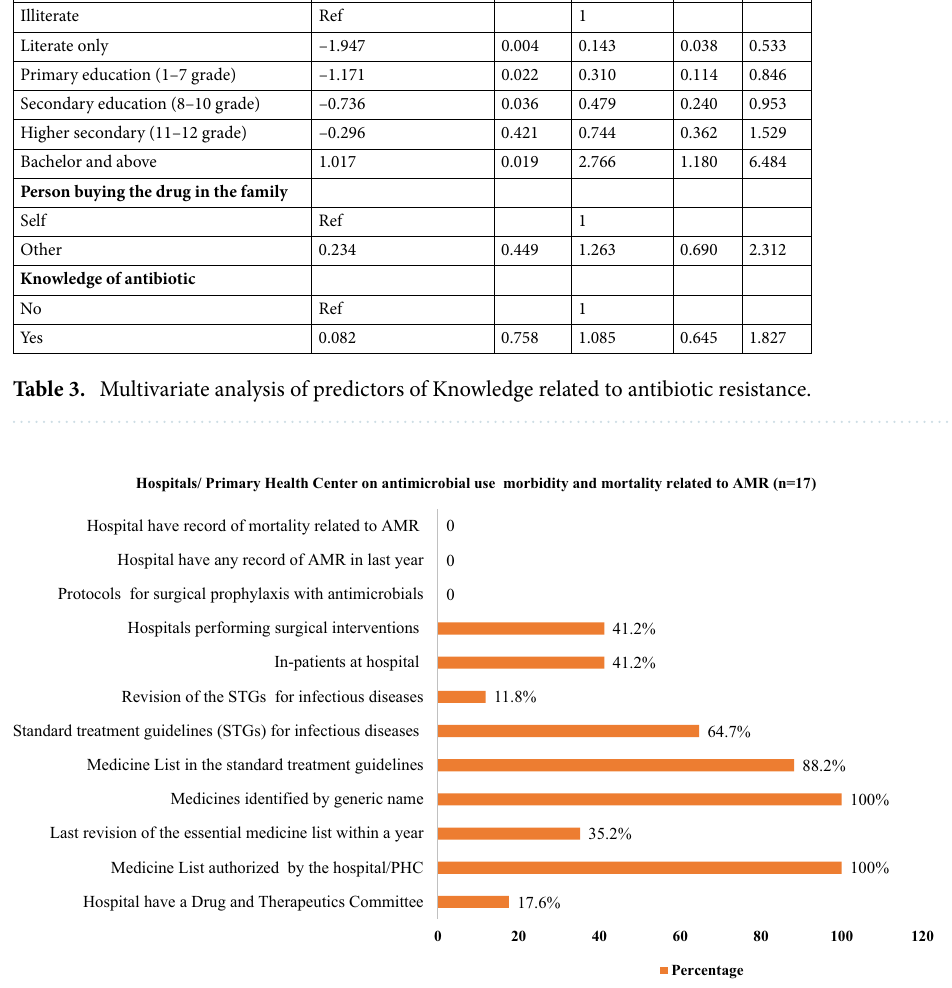
Figure 3. Hospitals provisions on antimicrobial use and morbidity and mortality related to AMR from Hospital/ PHC